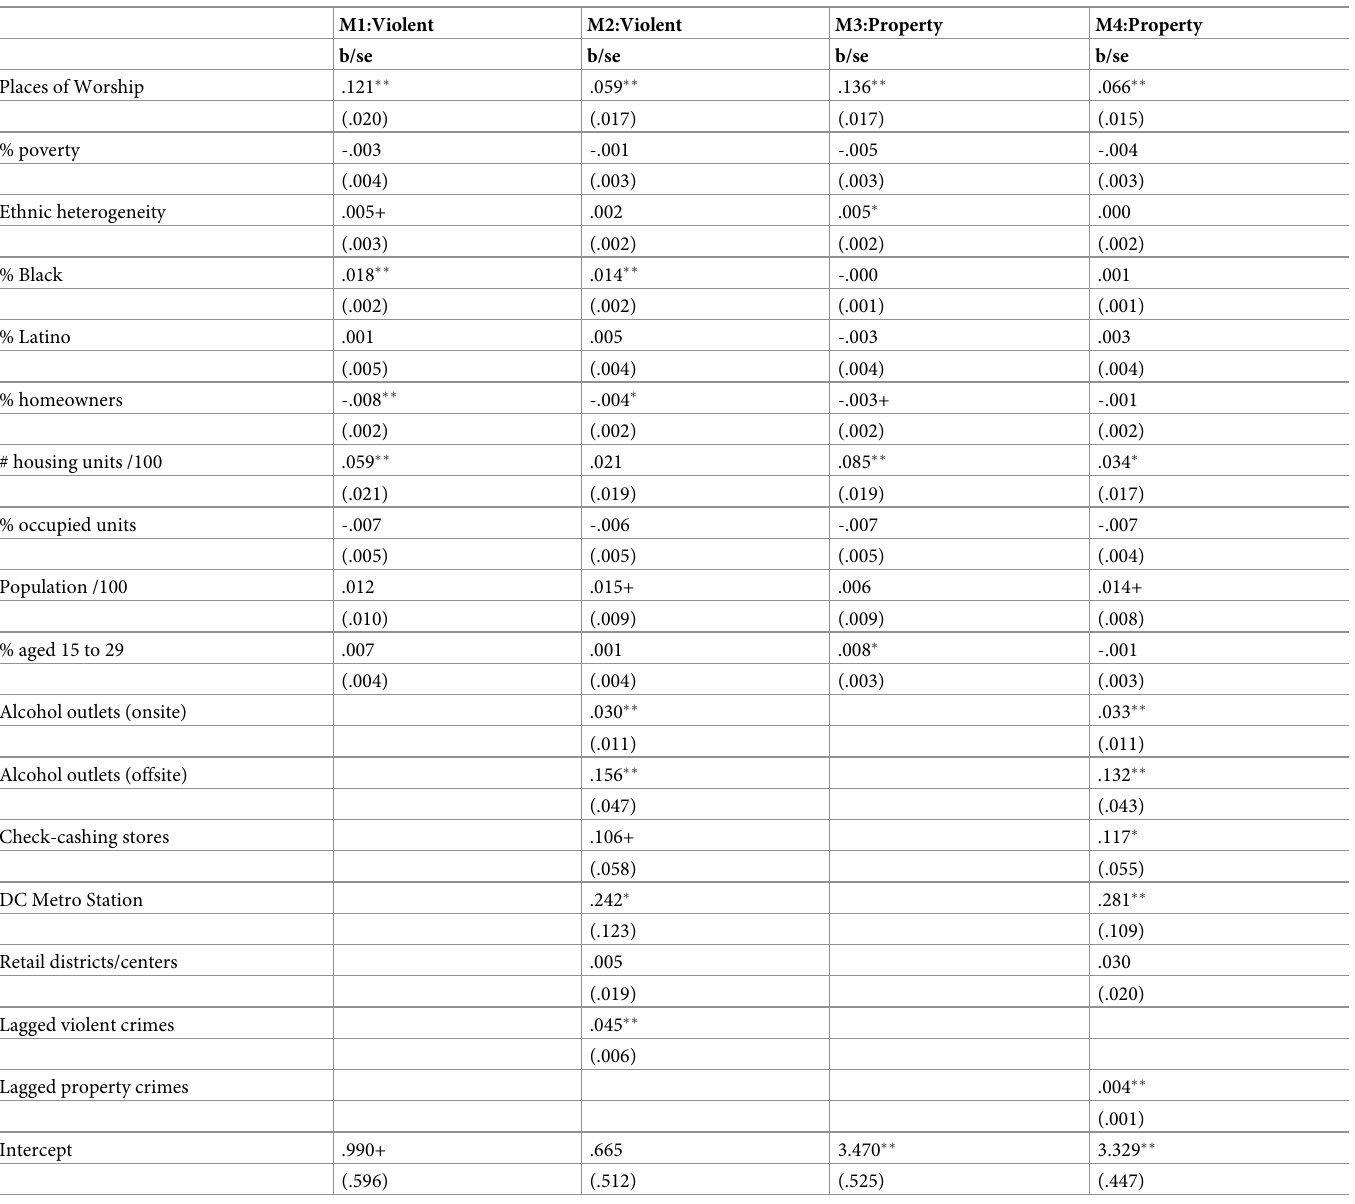
Table 2. POW effects on neighborhood